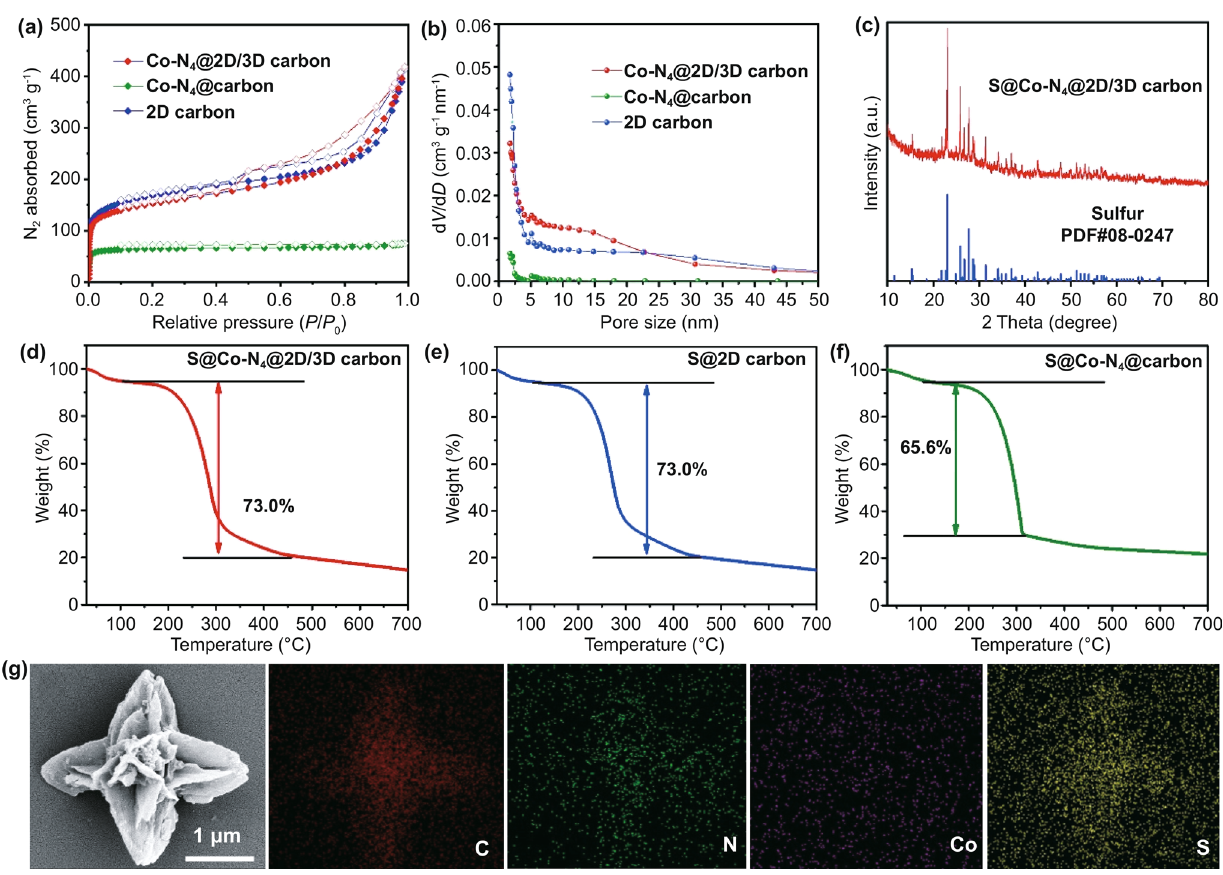
Fig. 3 a N 2 sorption isotherms based on the Barrett–Joyner–Halenda (BJH) method and b the pores distribution of Co–N 4 @2D/3D carbon, Co–